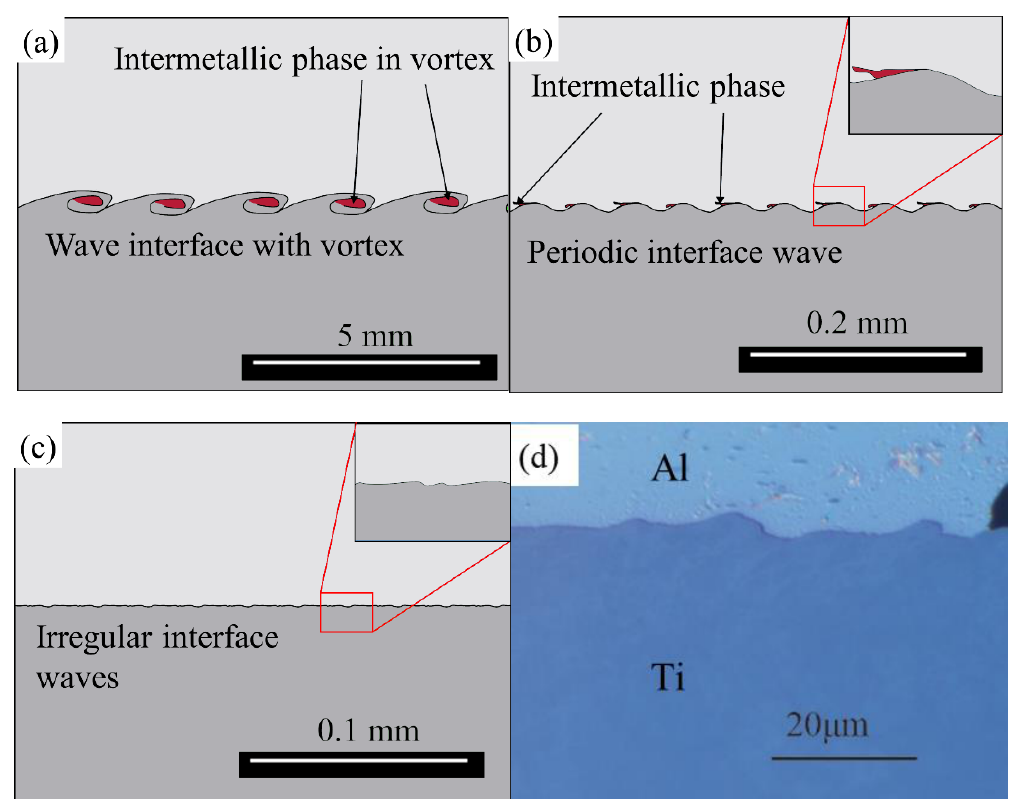
Figure 8. Weld interface morphology of three typical impact welded joints with ( a ) Explosive welding; ( b ) Magnetic pulse welding; ( c ) Laser impact welding; ( d ) Weld wave interface morphology with laser impact welding (reproduced from [24], with permission of Laser Institute of America 2016).